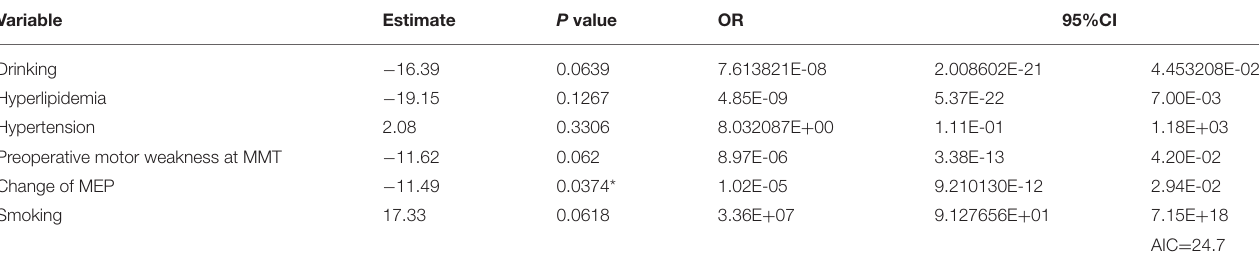
TABLE 3 | Results of logistic regression analyses regarding the preservation of motor function at the final follow-up and the Akaike Information Criterion (AIC) values. Variable